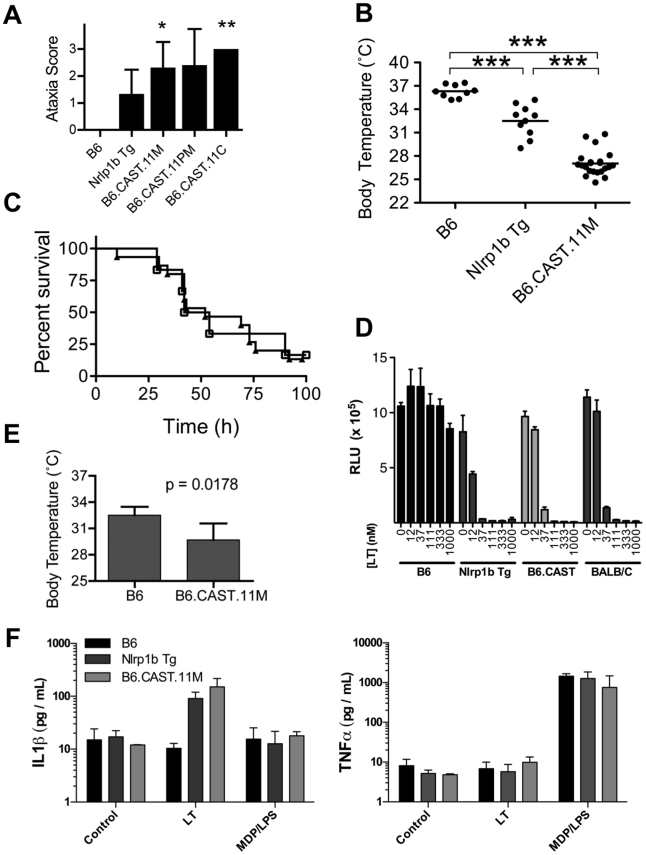
Identification of severe early response phenotype in B6.CAST.11 mice.B6.CAST.11M mice (n = 16), B6.CAST.11PM mice (n = 5), B6.CAST.11C mice (n = 5), mice expressing a LT-sensitive allele of Nlrp1b (B6Nrlp1b
(129S1)) (n = 15), or control B6 animals (n = 6) were injected i.p. with 5 µg PA+2.5 µg LF per g body weight and were scored for ataxia severity (A) and survival (C). A, Animals were scored on a 0–3 scale in which numbers represent the following walking ataxia scores: 0 =  no ataxia; 1 =  mild; 2 =  moderate; 3 =  severe, immobile, or moribund. See Materials and Methods for the definition of the ataxia scoring scale. The highest ataxia score during 7 h post injection is plotted +/− SD. P values calculated by Kruskal-Wallis nonparametric test with Dunn's post test. *p<0.05; **p<0.01 compared with B6. B, B6.CAST.11M (n = 22), B6Nrlp1b
(129S1) (n = 10), or control B6 animals (n = 9) were challenged i.p. with 15 µg PA+7.5 µg LF per g body weight (equivalent in activity to dose used in A, C) and the lowest temperature observed during the first 5 h post toxin injection is plotted. ***p<0.001 calculated by 1-way ANOVA with Tukey post test. C, Animals were monitored for presentation of clinical signs associated with terminal LT-induced disease and euthanized upon reaching a moribund state. Data represent time to euthanasia following LT injection. Symbols represent: squares, B6 (n = 6); triangles, B6.CAST.11M (n = 16). D, BMDMs derived from the indicated mouse strains were seeded in 96-well plates and treated with increasing concentrations of PA and LF for 4 h. Viability was assessed using ATPlite 1-step reagent (Perkin Elmer). Average luminescence values of triplicate samples are graphed +/− SEM. E, Mice (n = 5 / group) were injected i.p. with 5 µg/g MDP 4 h prior to i.p. challenge with 1 µg/g LPS. Rectal temperature was then measured hourly, and the lowest body temp achieved by each animal within 4 h is graphed +/− SD. P-value was calculated from unpaired two-tail t-test. F. BMDMs derived from the indicated mouse strains were seeded in 96-well plates then challenged with 250 ng/mL LT for 3 h or 0.1 µg/mL MDP +0.1 ng/mL LPS for 8 h. Culture supernatants were then analyzed for IL-1β and TNFα as described in methods. Data represent average values +/− SD.